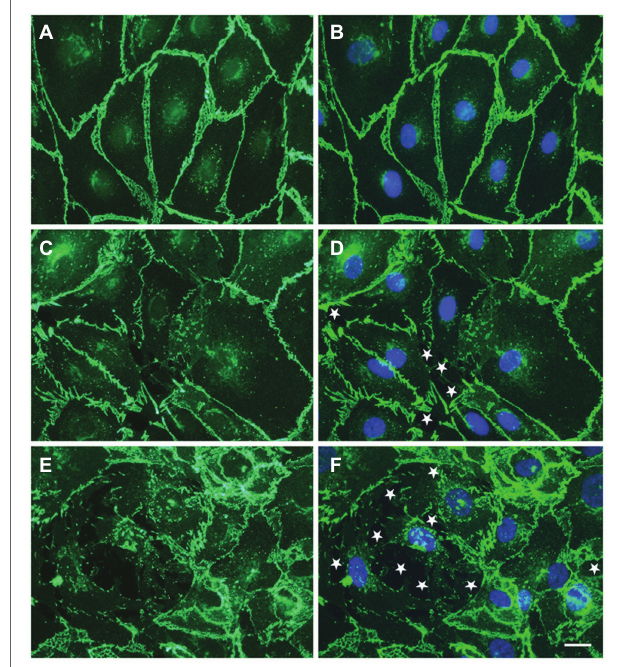
FIGURE 1 | Circulating small extracellular vesicles (EVs) from sickle cell patients cause damage to endothelial cell monolayers. (A–F) representative photomicrographs show the localization of VE-cadherin (green) and nuclei (blue in B,D,F ) in endothelial cells 48 h following treatment with no EVs (A,B) or EVs from a subject with sickle cell disease (SCD) purified by precipitation (C,D) or by size exclusion chromatography (E,F) . White stars indicate spaces between cells. Scale bar is 20 μ m. In the examples shown, the monolayer disruption was 0% (A,B) , 1.9% (C,D) , or 7.5% (E,F) . This figure contains different examples illustrating the observations in our previous publication (Lapping-Carr et al., 2017,